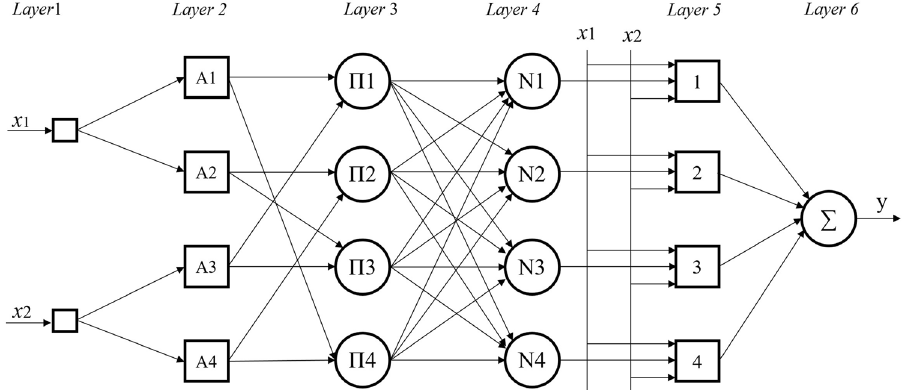
Fig. 2 Architecture of a